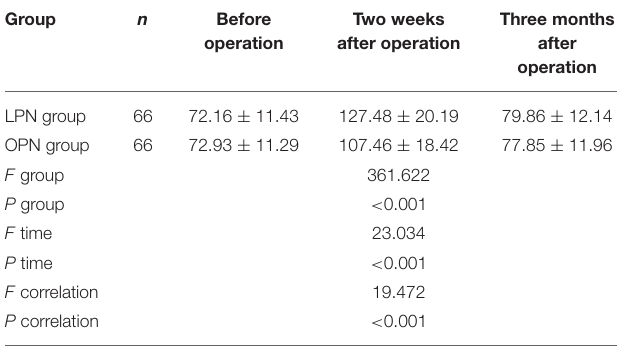
TABLE 1 | Comparison of SCr level ( x ± s, µ